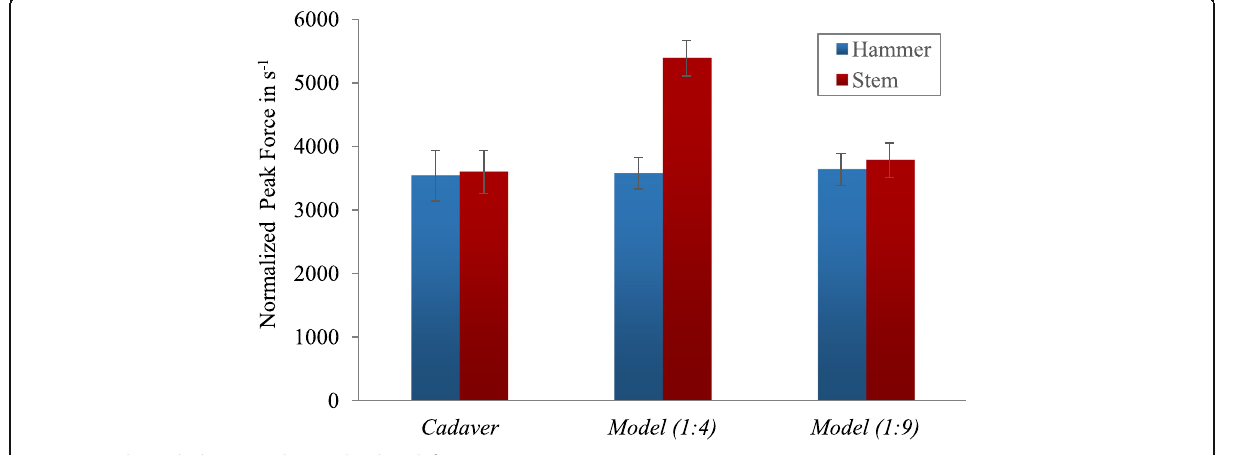
Fig. 6 Box plot with determined normalized peak